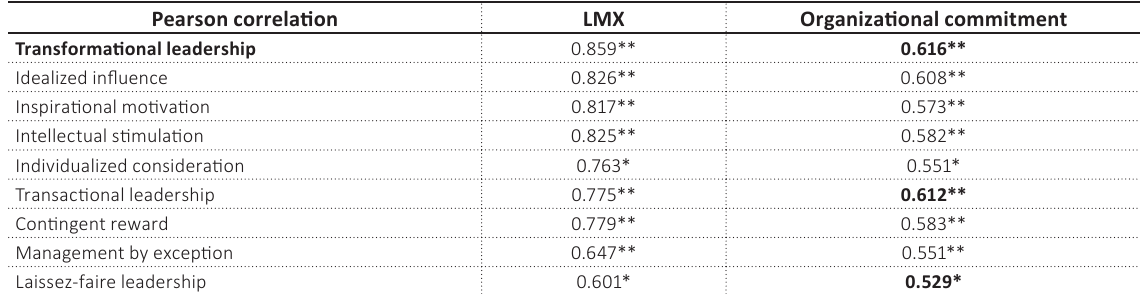
Table 4. Correlations between transformational leadership, transactional leadership, LMX and